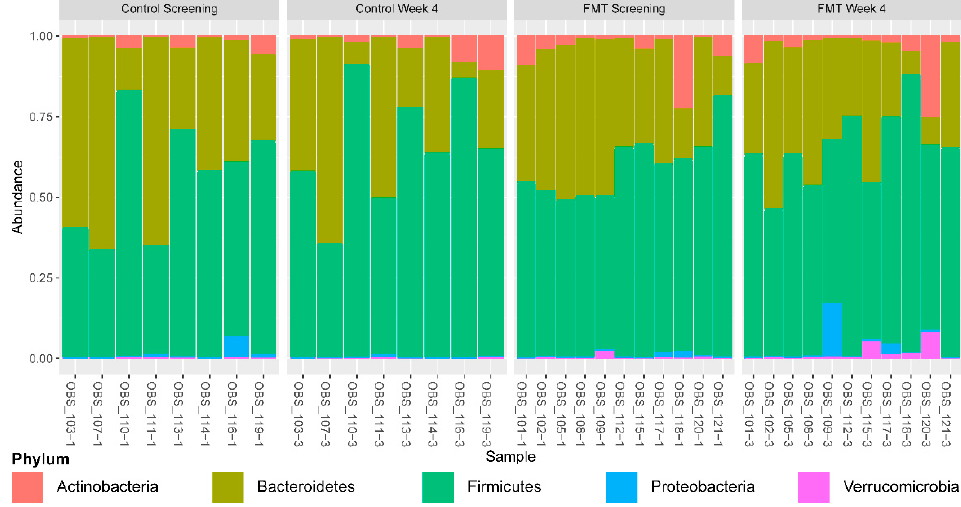
Figure 1. Phylum-level relative abundances across all individual patients. Patient identifiers ending in 1 represent baseline and ending in 3 represent the 4-week time point. Plots are faceted by treatment and time point.